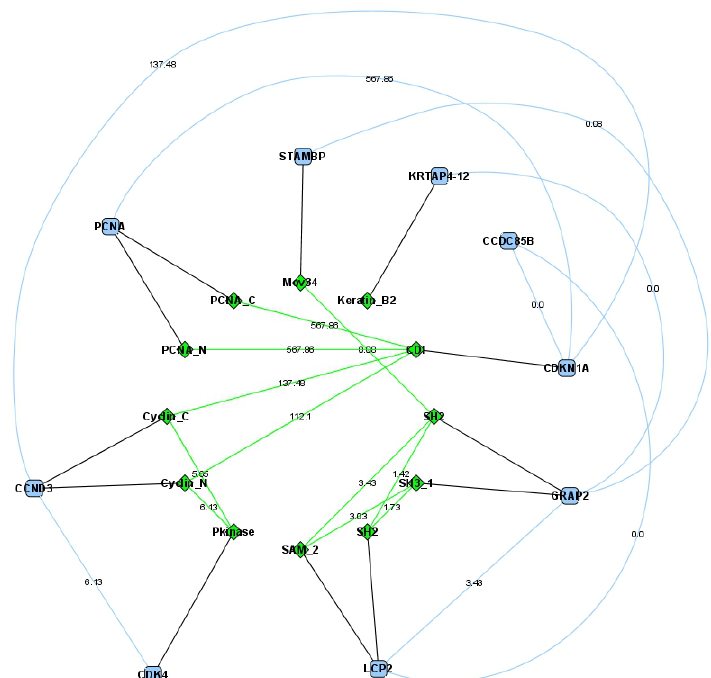
Figure 1: Sample domain graph. Protein nodes (blue rectangles) are located on the outer circle, domain nodes (green diamonds) on the inner circle. Protein interaction edges are shown in blue, domain interaction edges in green, and protein domain linkers in black (see Section